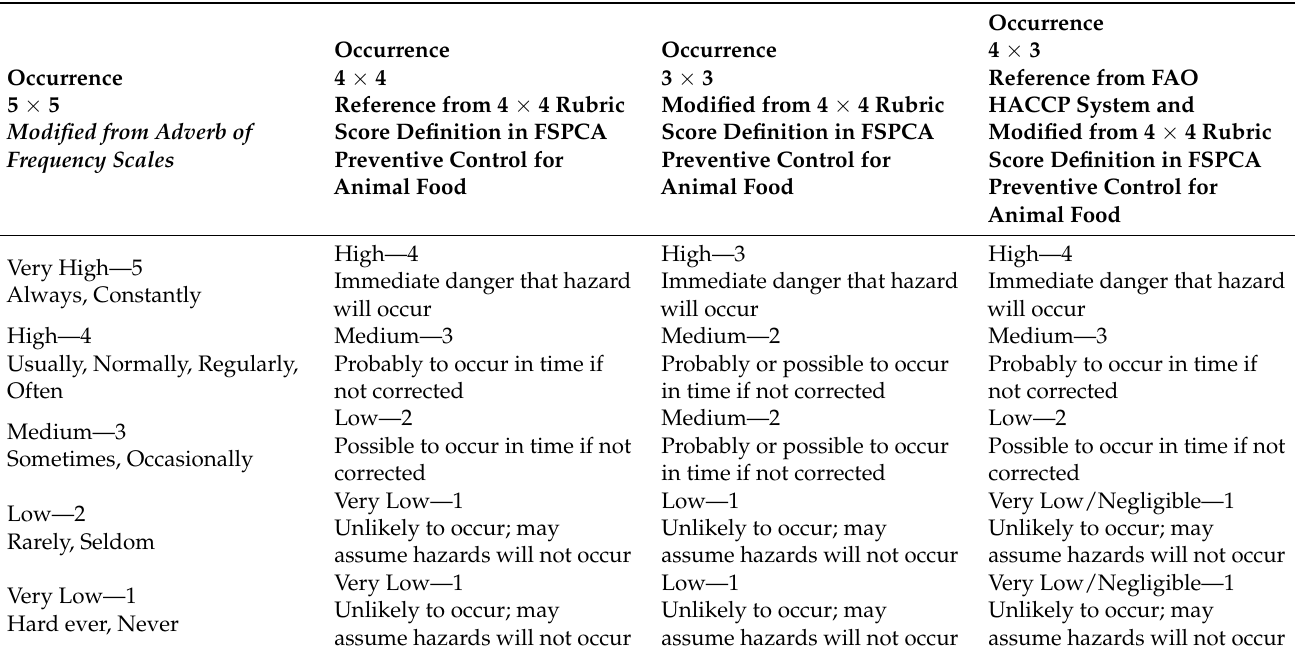
Table 4. All qualitative food safety risk matrix models’ occurrence or probability scores summary.